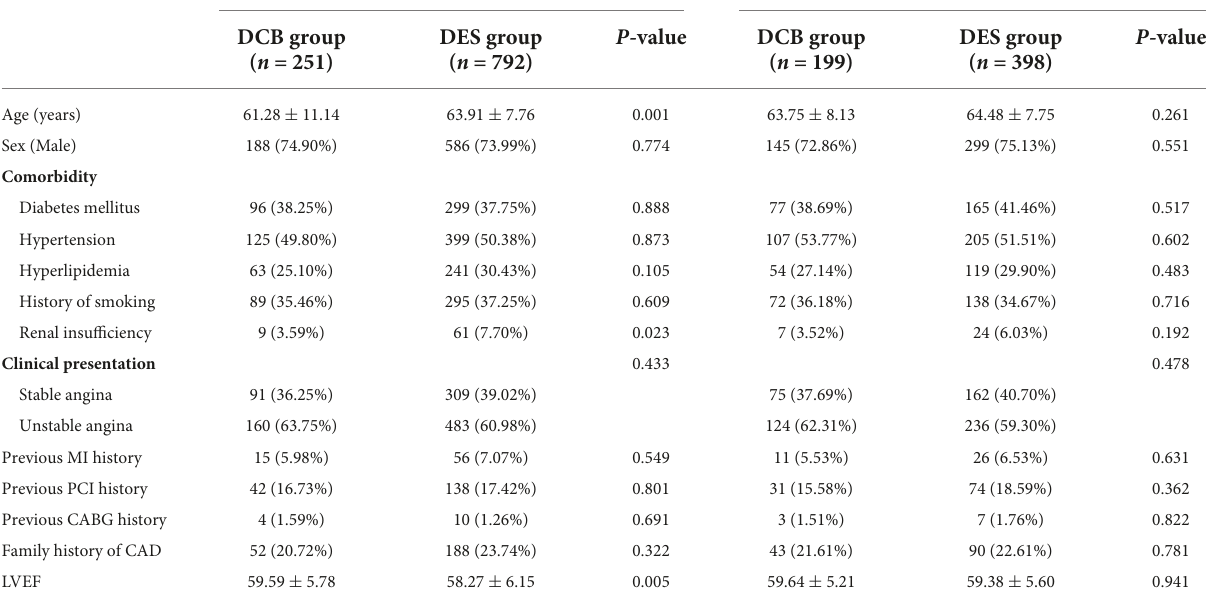
TABLE 1 Demographic characteristics before and after propensity-score matching*.